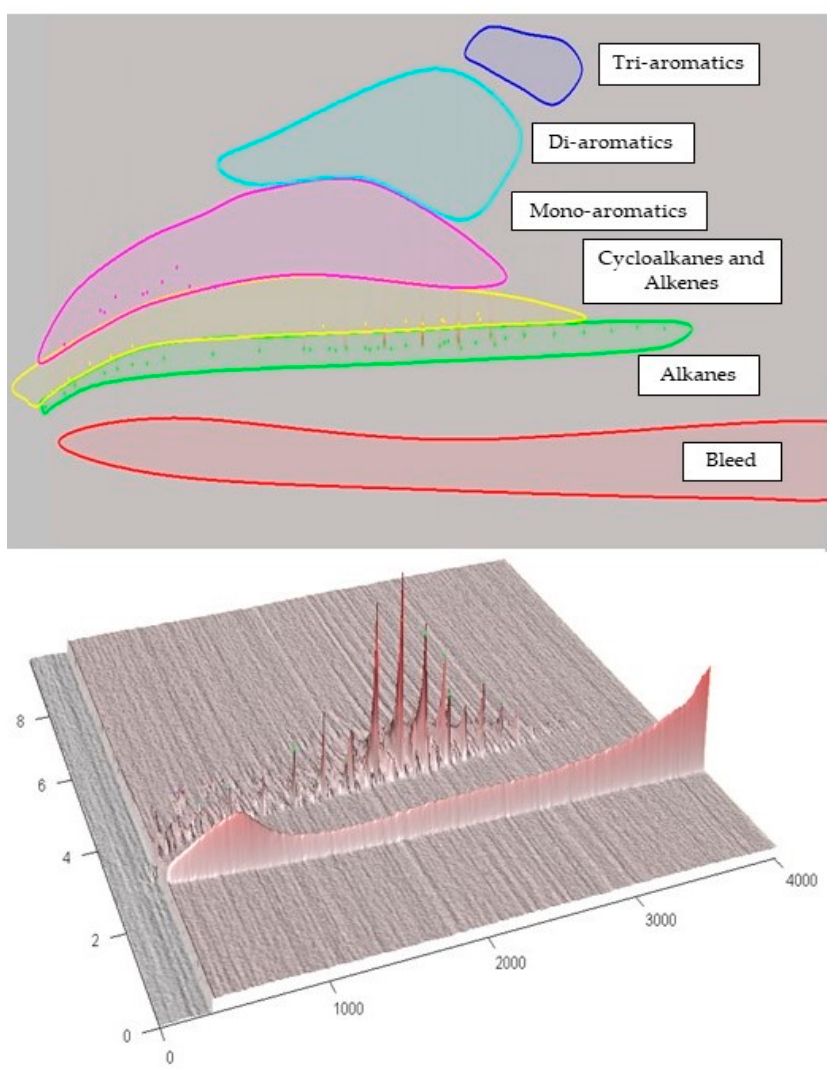
Figure 8. Representative average sample prior to the deactivation procedure.